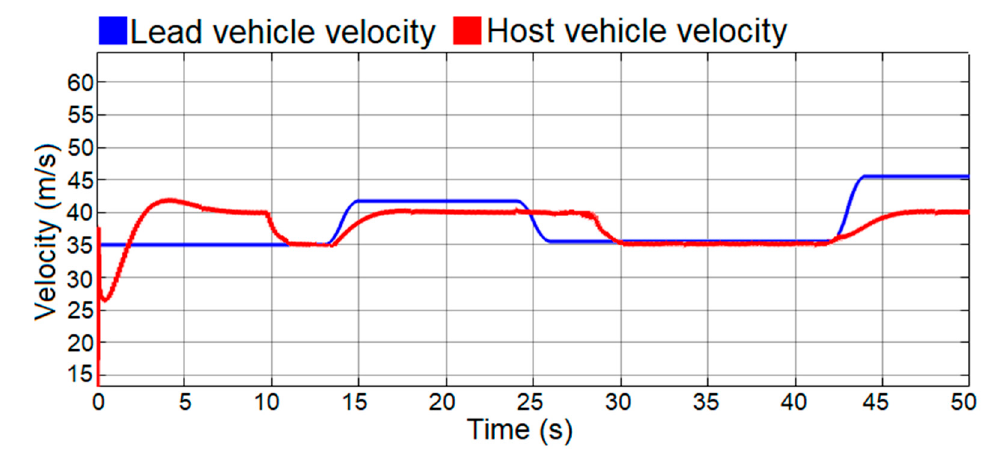
Figure 16. Velocity of the leading vehicle and host vehicle (results from simulation).